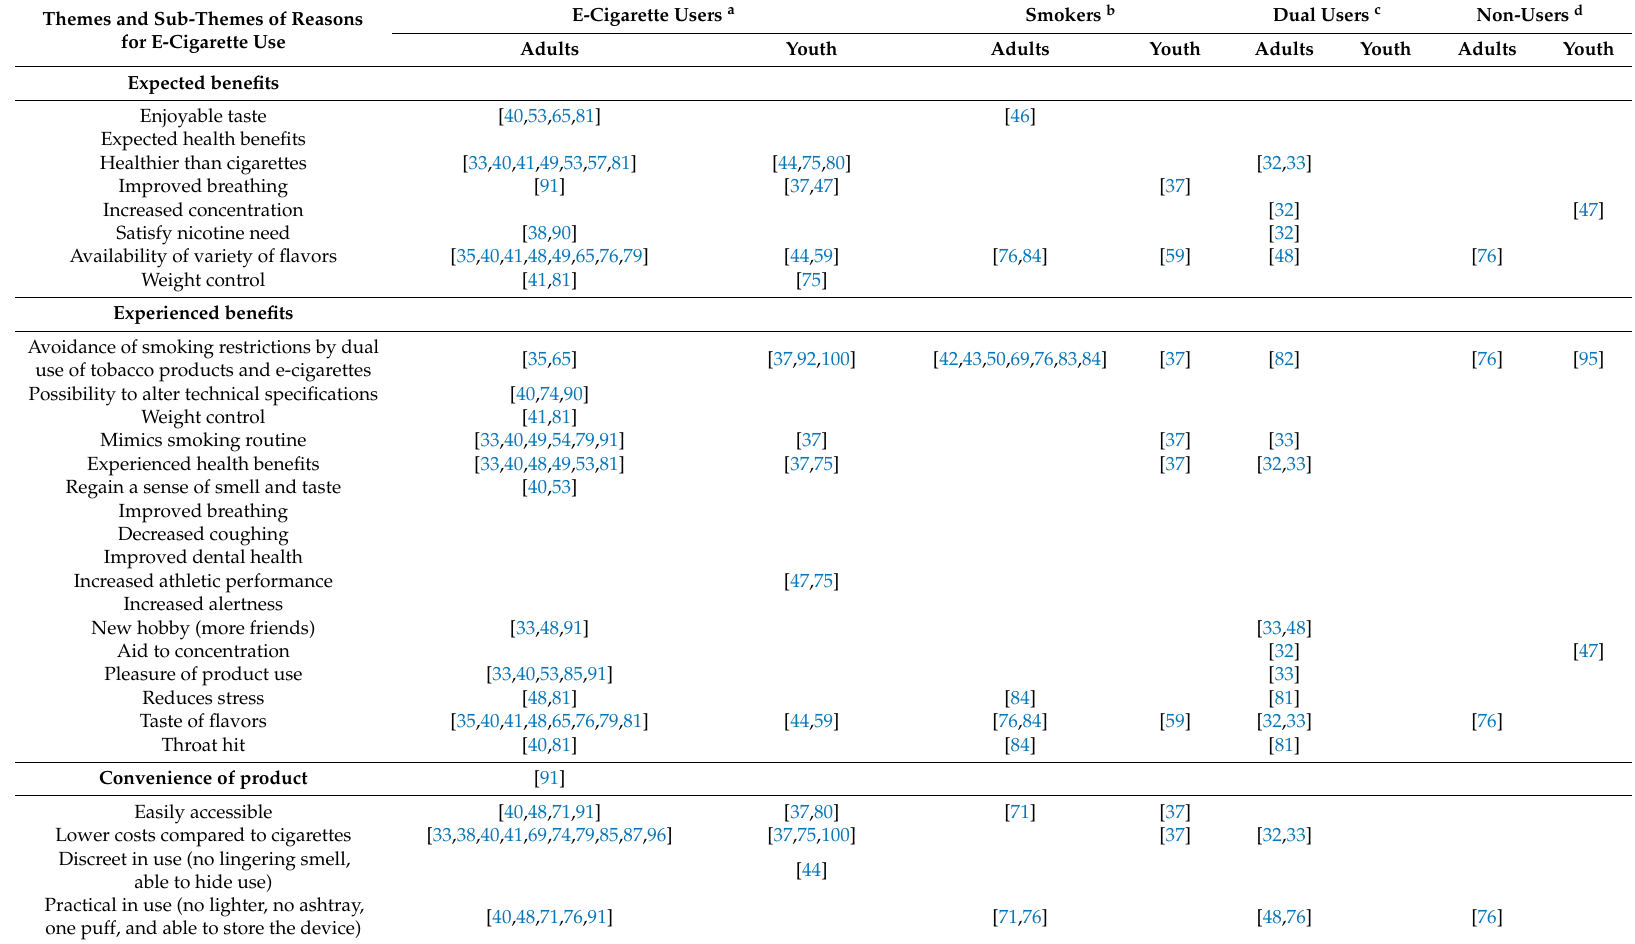
Table 3. Reasons for e-cigarette use as reported by individual studies by type of